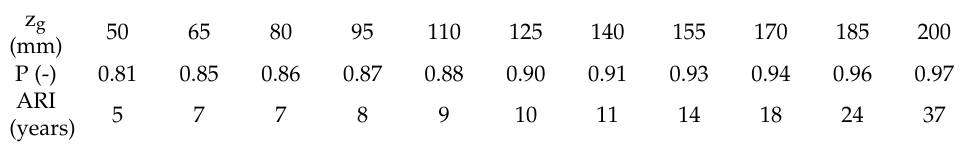
Table 4. Analysis results on the whole period of records, GREEN ROOF